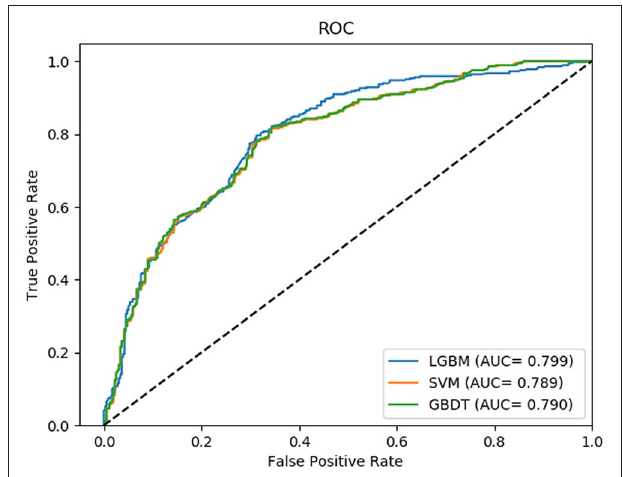
FIGURE 2 | The ROC curve of dataset RPI369 on three classifiers.